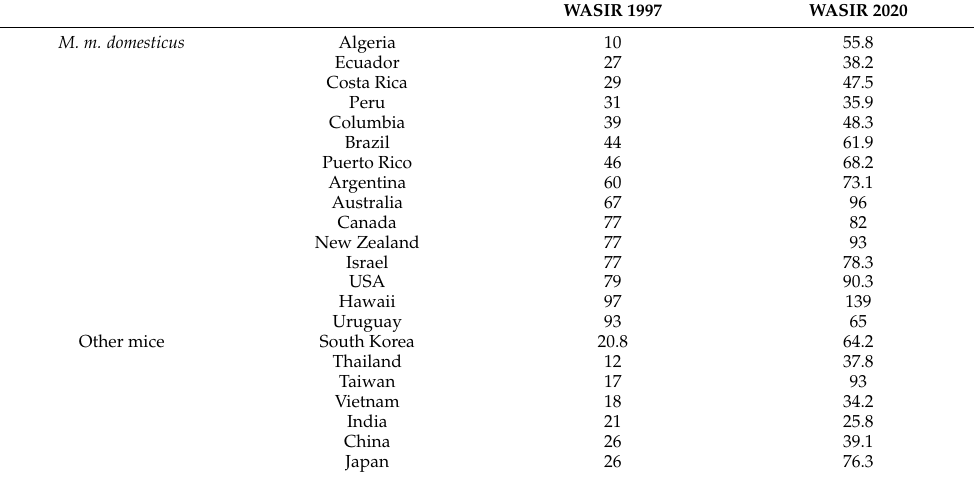
Table 2. Change in breast cancer incidence rate from 1997 to 2020 in non-European lands (excluding sub-Saharan Africa) according to the range of M. m. domesticus